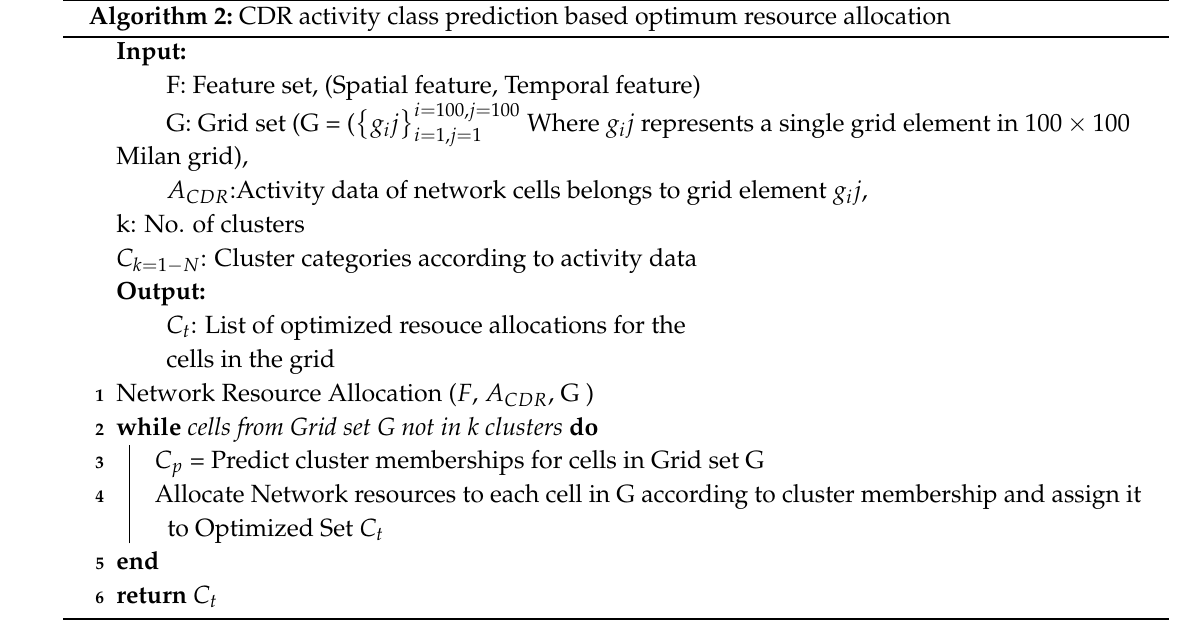
Algorithm 2: CDR activity class prediction based optimum resource allocation